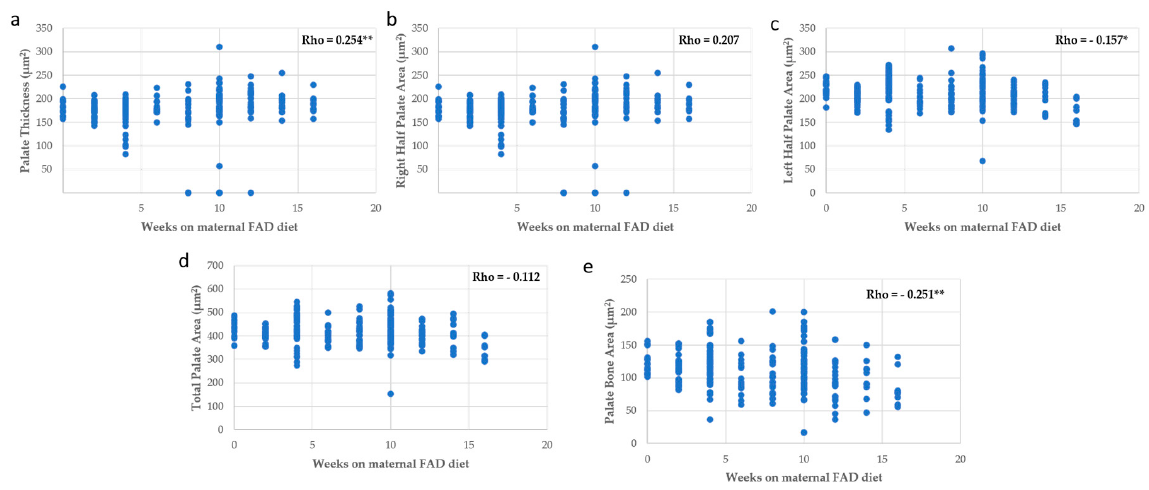
Figure 6. Correlations between palate measurements with weeks on maternal FAD diet. ( a ) Palate thickness; ( b ) right half palate area; ( c ) left half palate area; ( d ) total palate area and ( e ) palate bone area. * p ≤ 0.05; ** p ≤ 0.01.